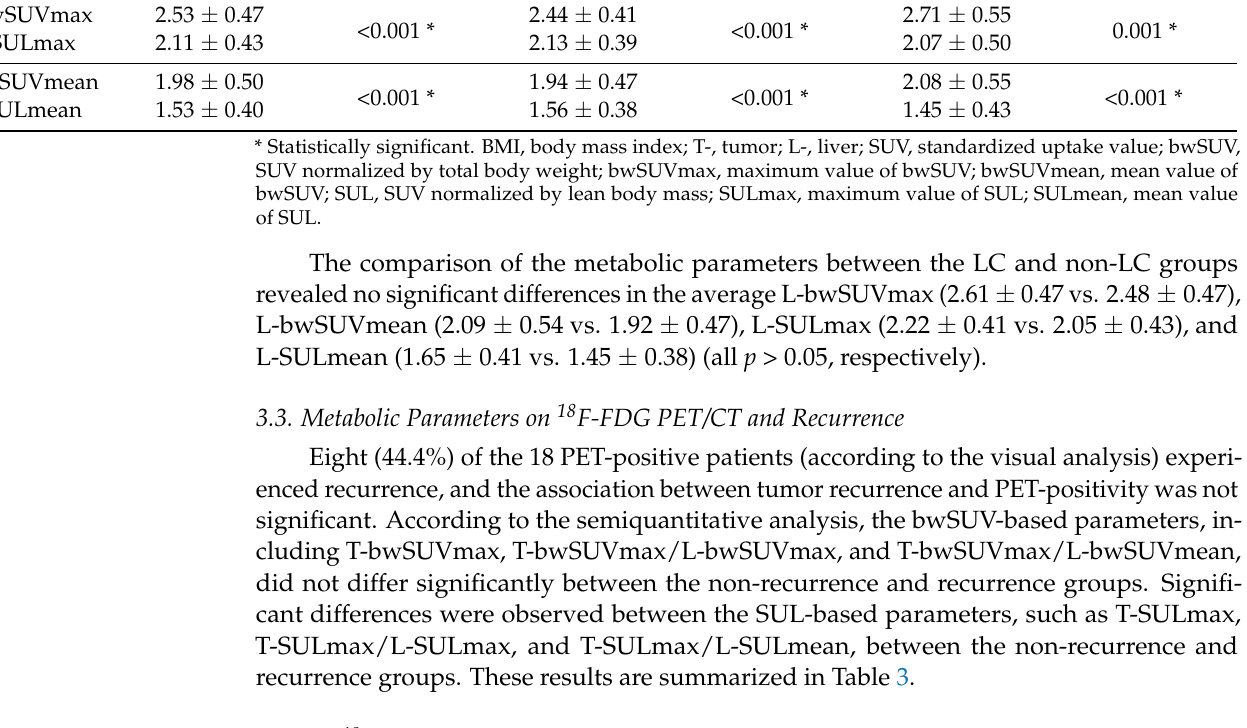
Table 3. 18 F-fluorodeoxyglucose positron emission tomography/computed tomography findings according to